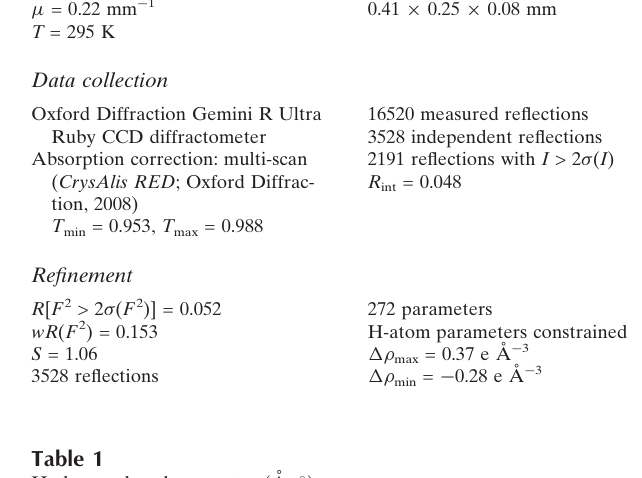
Hydrogen-bond geometry (A˚ , (cid:4) ).